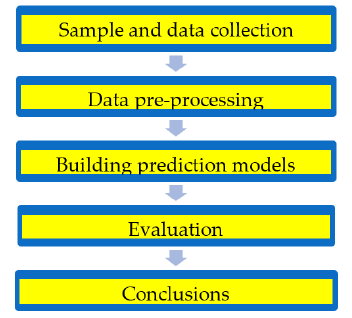
Figure 1. The experimental process.